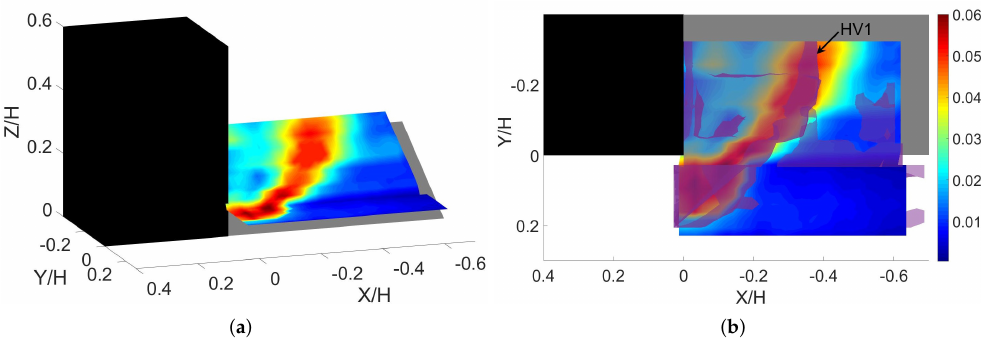
Figure 13. Distribution of the dimensionless bed mean bed shear stress values, ( a ) shows a 3D view, and ( b ) shows a top view along with the isosurfaces of the JV system at isovalue of 1.5.